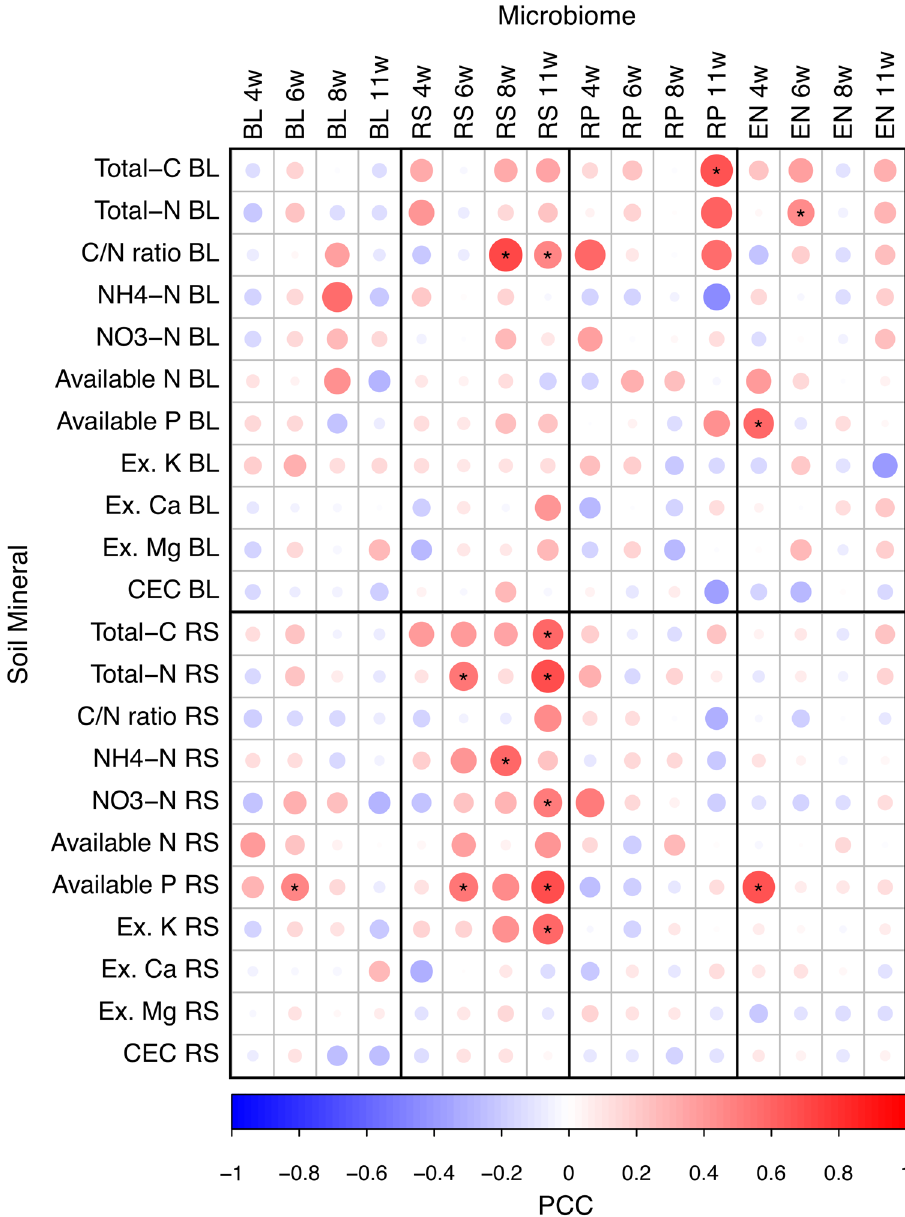
Figure 8. Mantel’s r statistics between root-associated bacterial communities and the soil environment. Mantel’s test was performed using weighted UniFrac (WUF) distance matrix and the Euclidian distance matrix of each mineral contents at each sampling time. Asterisks (*) show significant correlations ( p < 0.01). PCC, Pearson correlation coefficient; BL, bulk soil; RS, rhizosphere; RP, rhizoplane; EN, endosphere; Ex, exchangeable; CEC, cation exchange